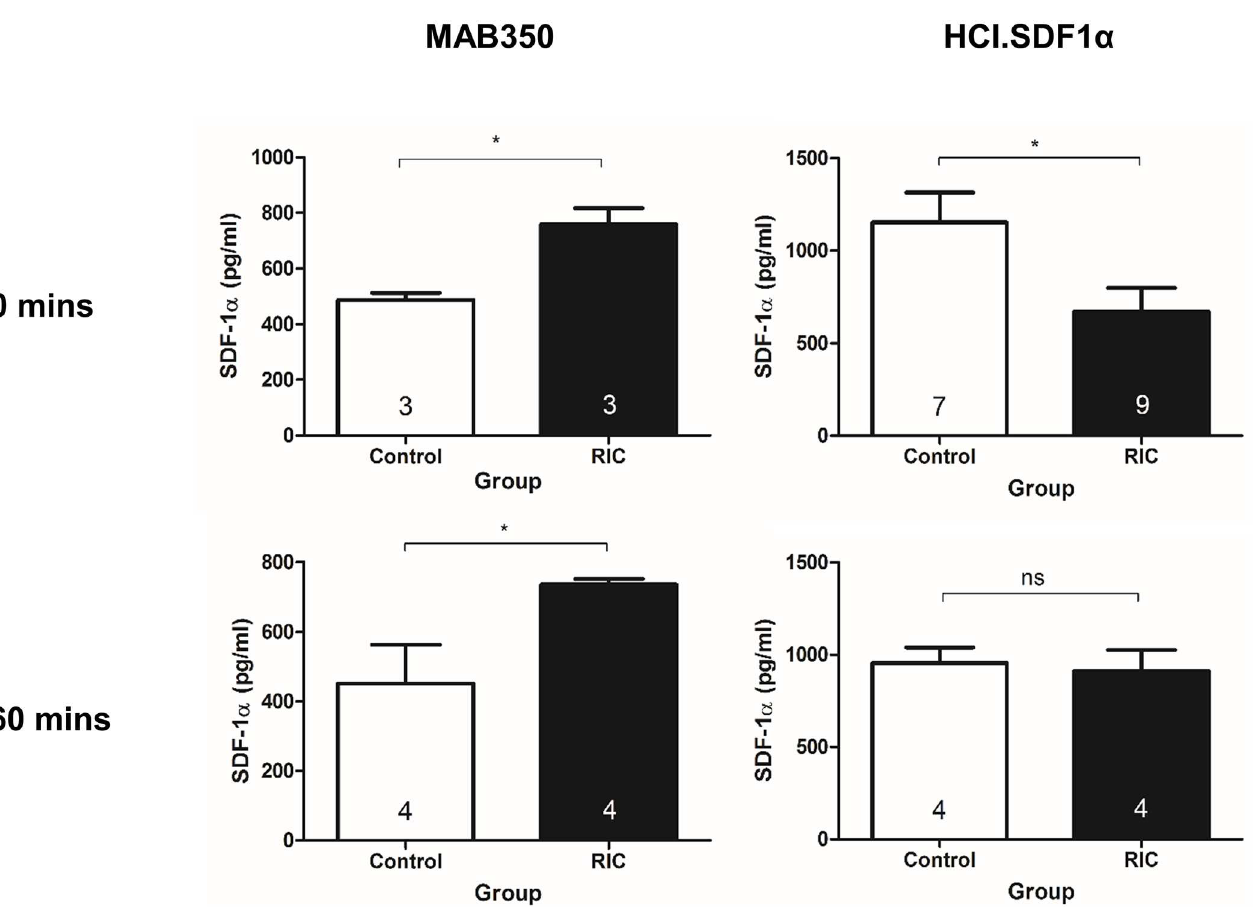
Fig 9. Effect of RIC on intact and cleaved SDF-1 α . FollowingRIC, ELISA using commercial antibodiesdetects an increasein plasma SDF-1 α levels whereasHCI.SDF1 α ,which is more specific for full-lengthSDF-1 α ,measuresa decreaseimmediately after RIC that is restored to baselineby 1